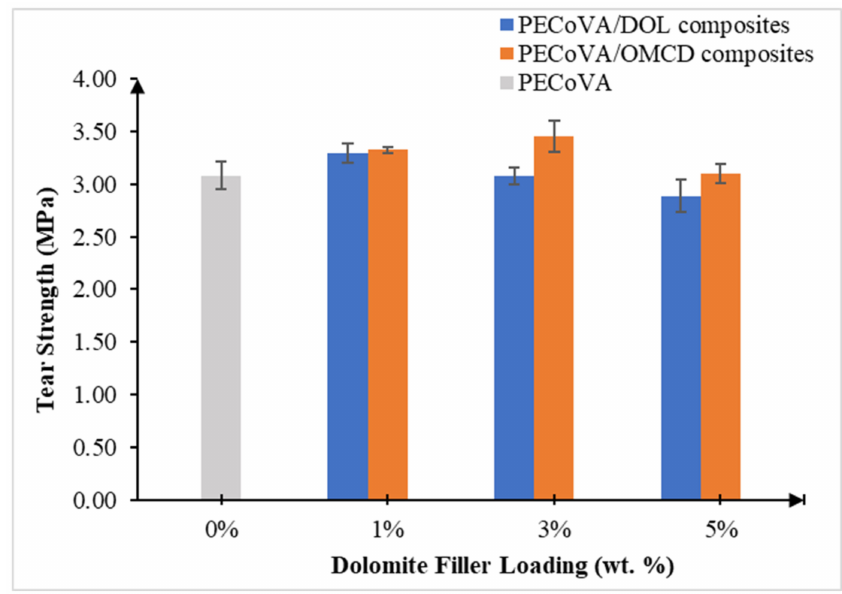
Figure 9. Effect of dolomite filler loading on the tear strength of virgin PECoVA, PECoVA/DOL and PECoVA/OMCD